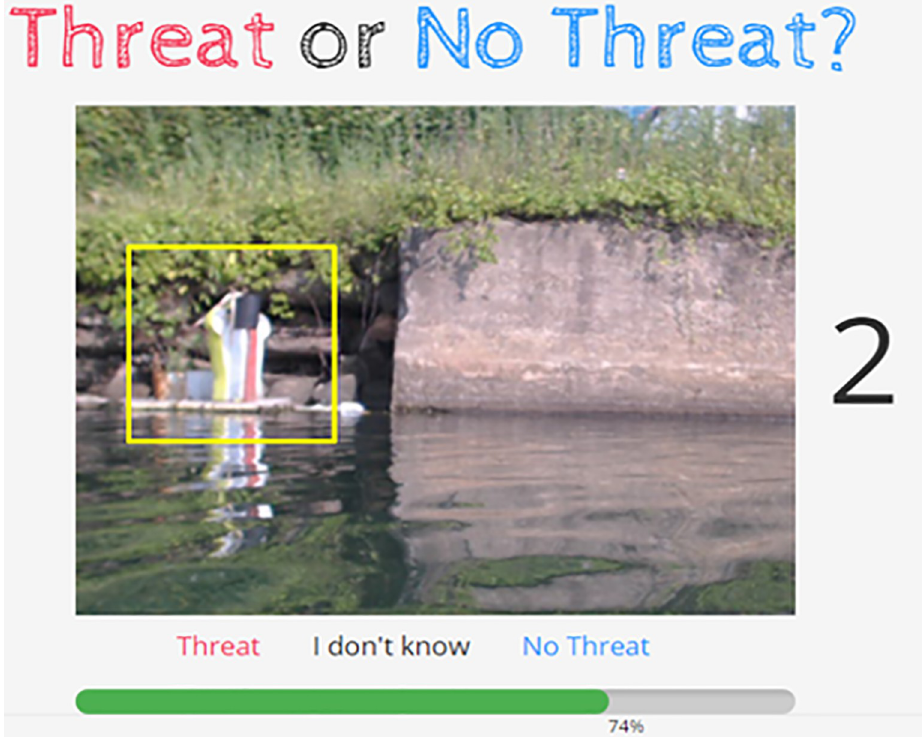
Fig 1. Screenshot of the image classification task. The object to be classified is highlighted by a rectangular frame. The number on the right (“2”) denotes the time remaining to answer the question in seconds. The bottom bar indicates the progress toward completing the classification of all images. The correct answer of this image is “no threat” (art installation).